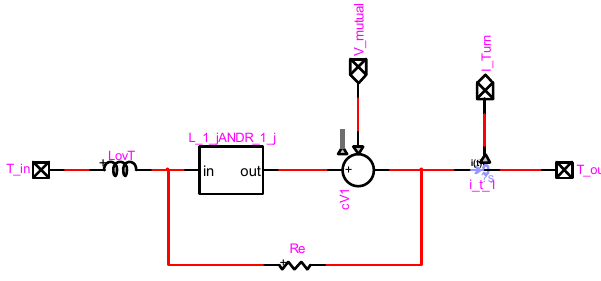
Figure 17. One coil model implemented in EMTP-RV.